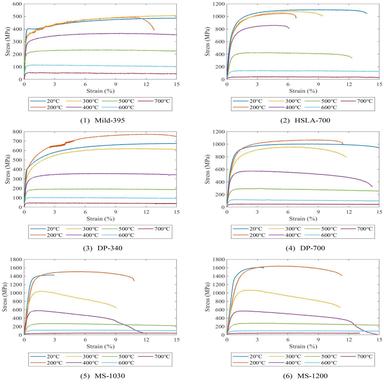
Stress-strain curves obtained from steady-state tests.